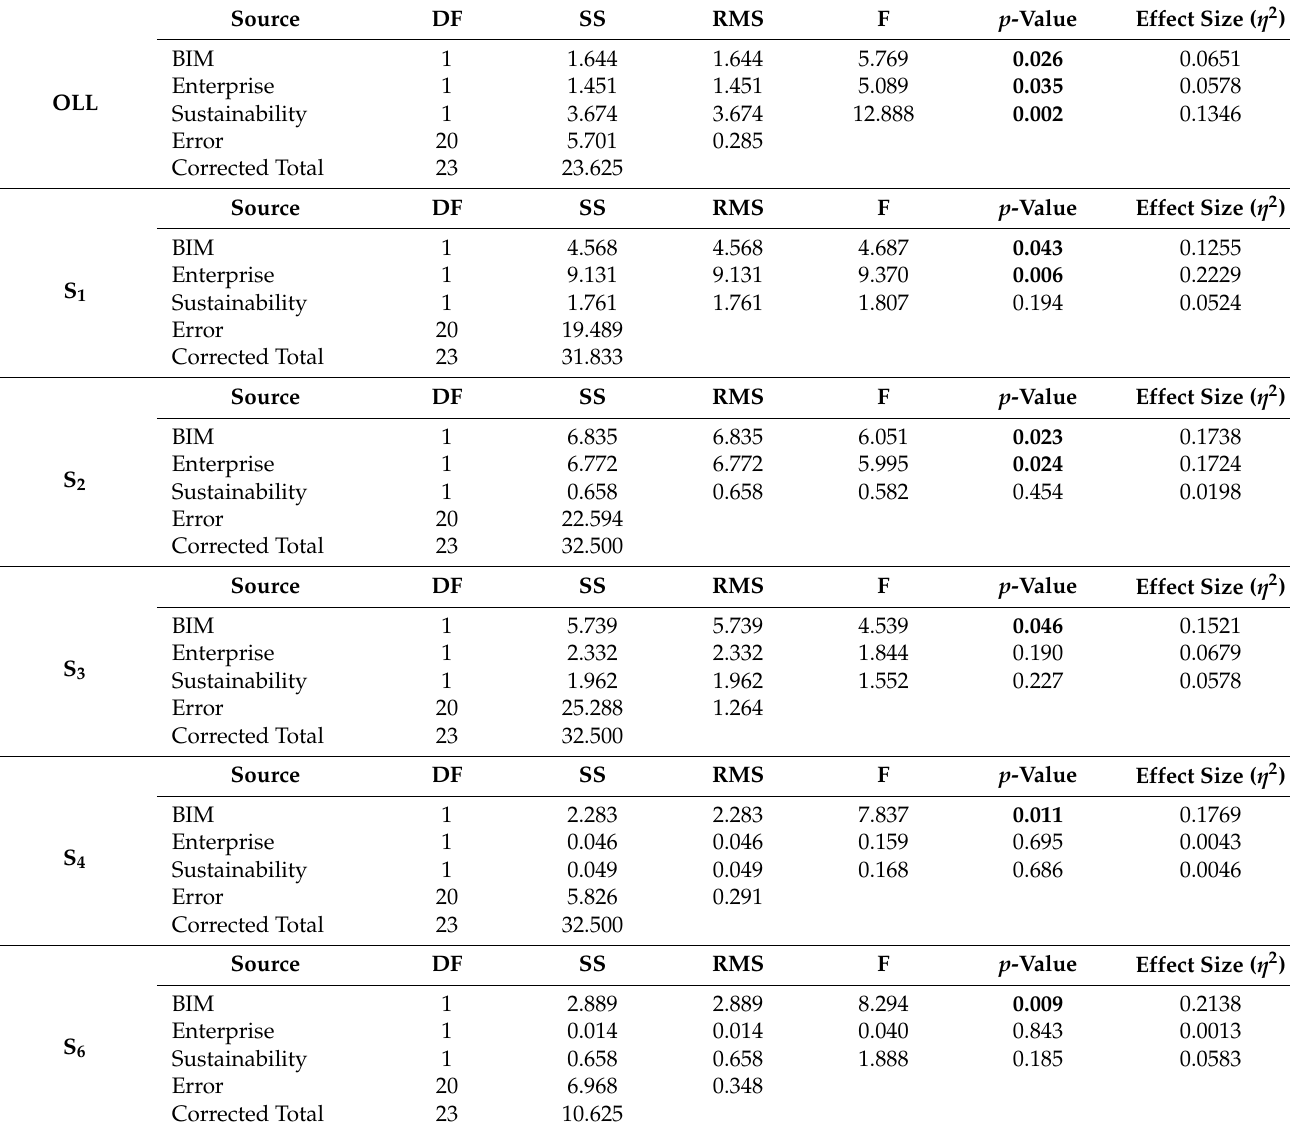
Table 12. Teacher evaluation of criteria: ANOVA